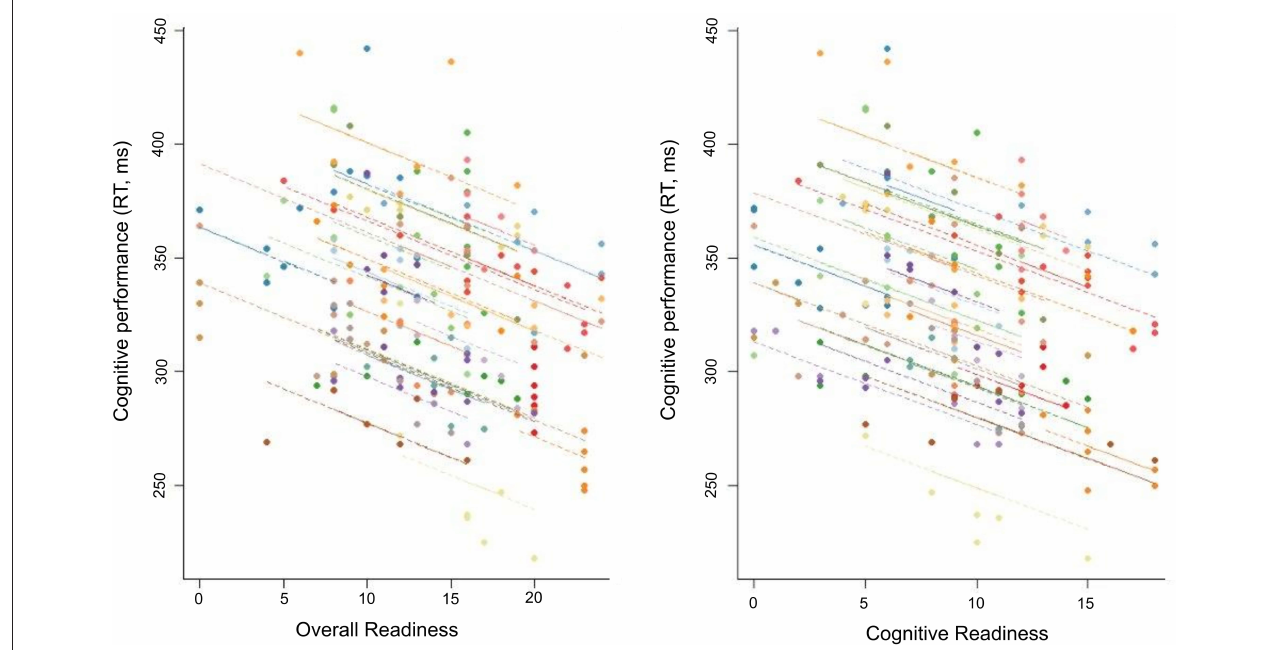
FIGURE 5 | Repeated-measures correlation between cognitive performance and two subscales (Overall Readiness, Cognitive Readiness) of the Acute Readiness Monitoring Scale (ARMS) for the overnight assessments (from 20:00 to 08:00h).